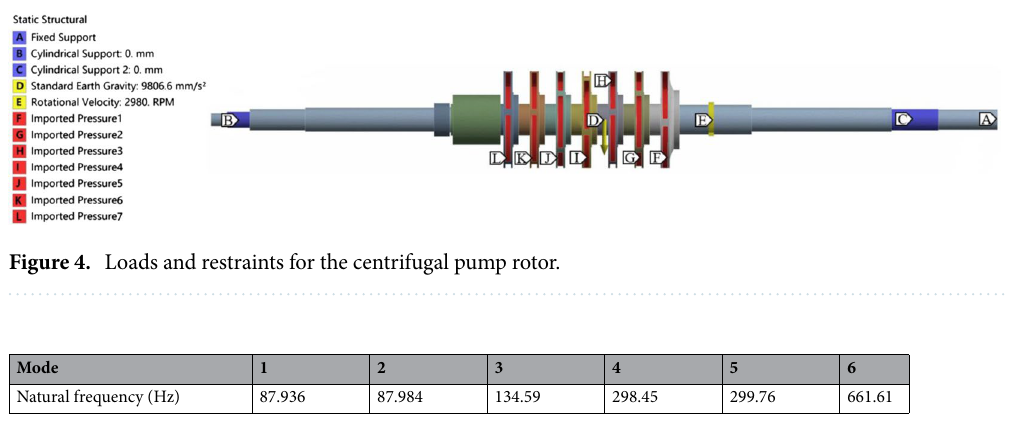
Table 3. The first six natural frequencies of the rotor system (unit: